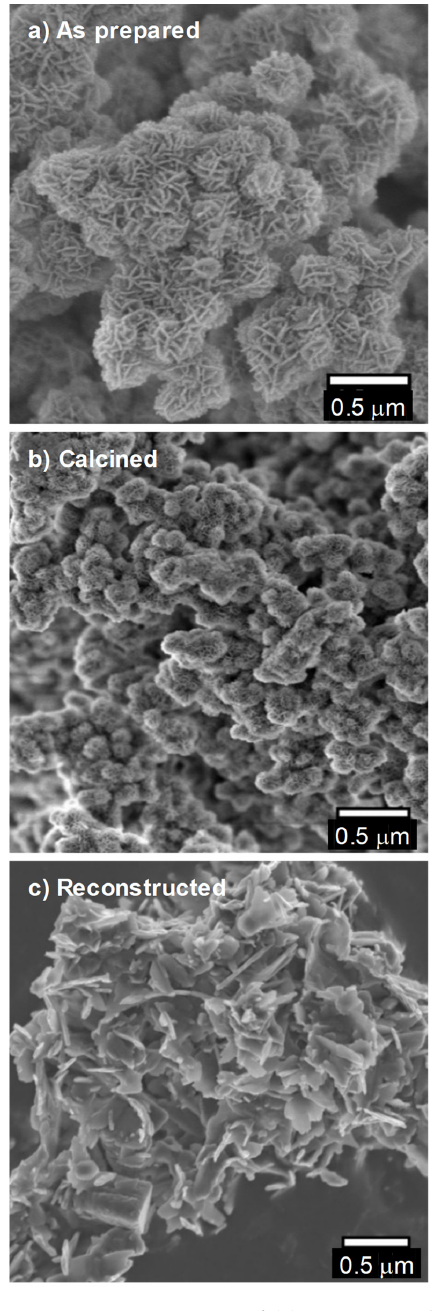
Figure 2. SEM images of ( a ) As-prepared; ( b ) Calcined; and ( c ) Hydrothermally reconstructed, al ‐ kali ‐ free Ni4.1Al LDH materials.